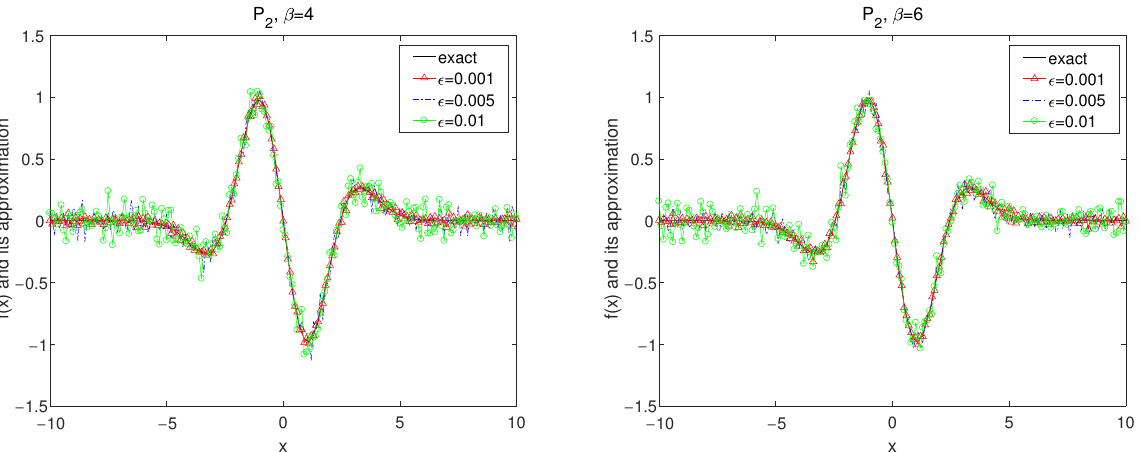
Figure 1. The exact solution and the regularized solutions with β = 4,6 using kernel P 1 under the a priori choice rule for Example 1.